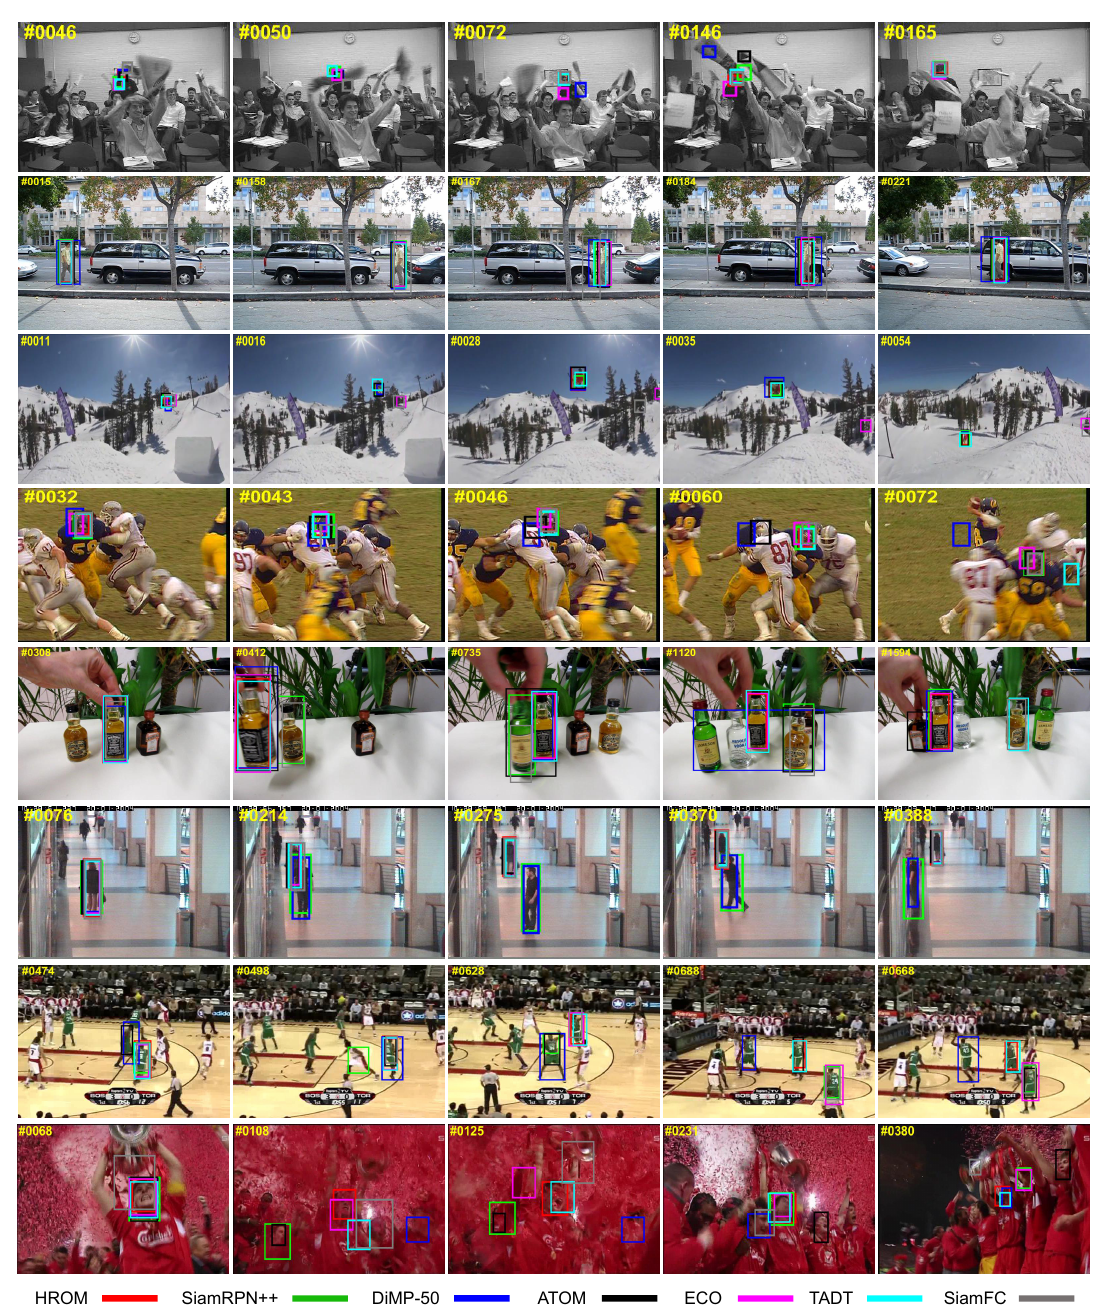
Figure 10. Qualitative evaluation of the proposed HROM and state-of-the-art tracking methods on